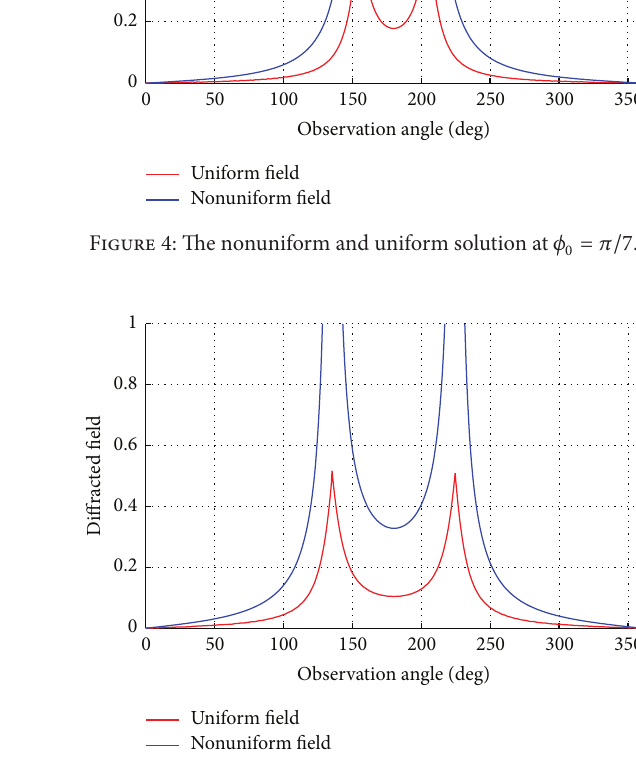
Figure 5: The nonuniform and uniform solution at 𝜙 0 = 𝜋/4